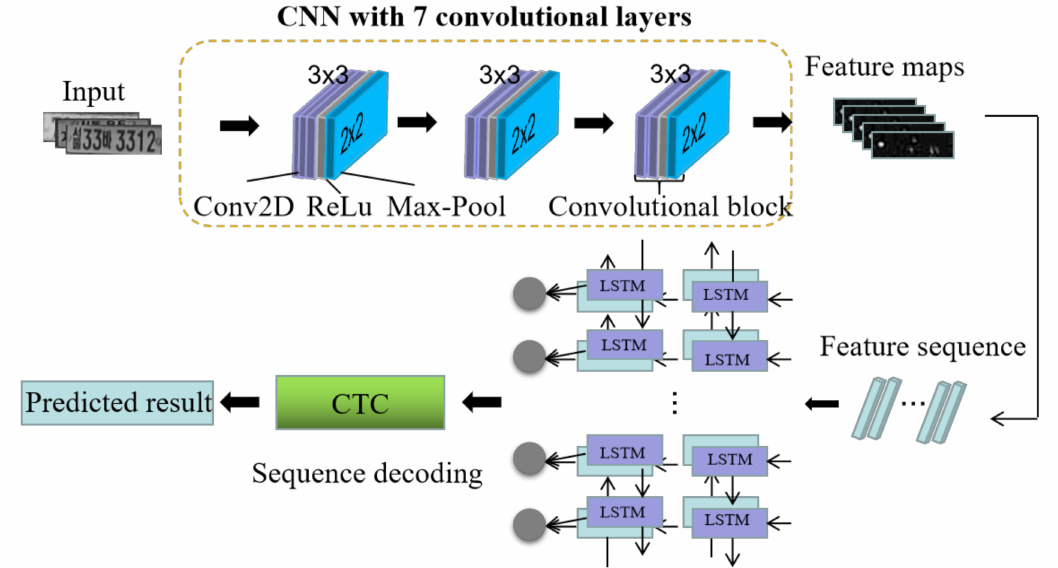
Figure 3. The architecture of the deep learning model for W-LPR. Firstly, a deep CNN is used to extract features and transform them into sequence representation. Secondly, LSTM is trained to obtain context information. Finally, CTC is applied as the last layer of the RNN model to give the final recognition